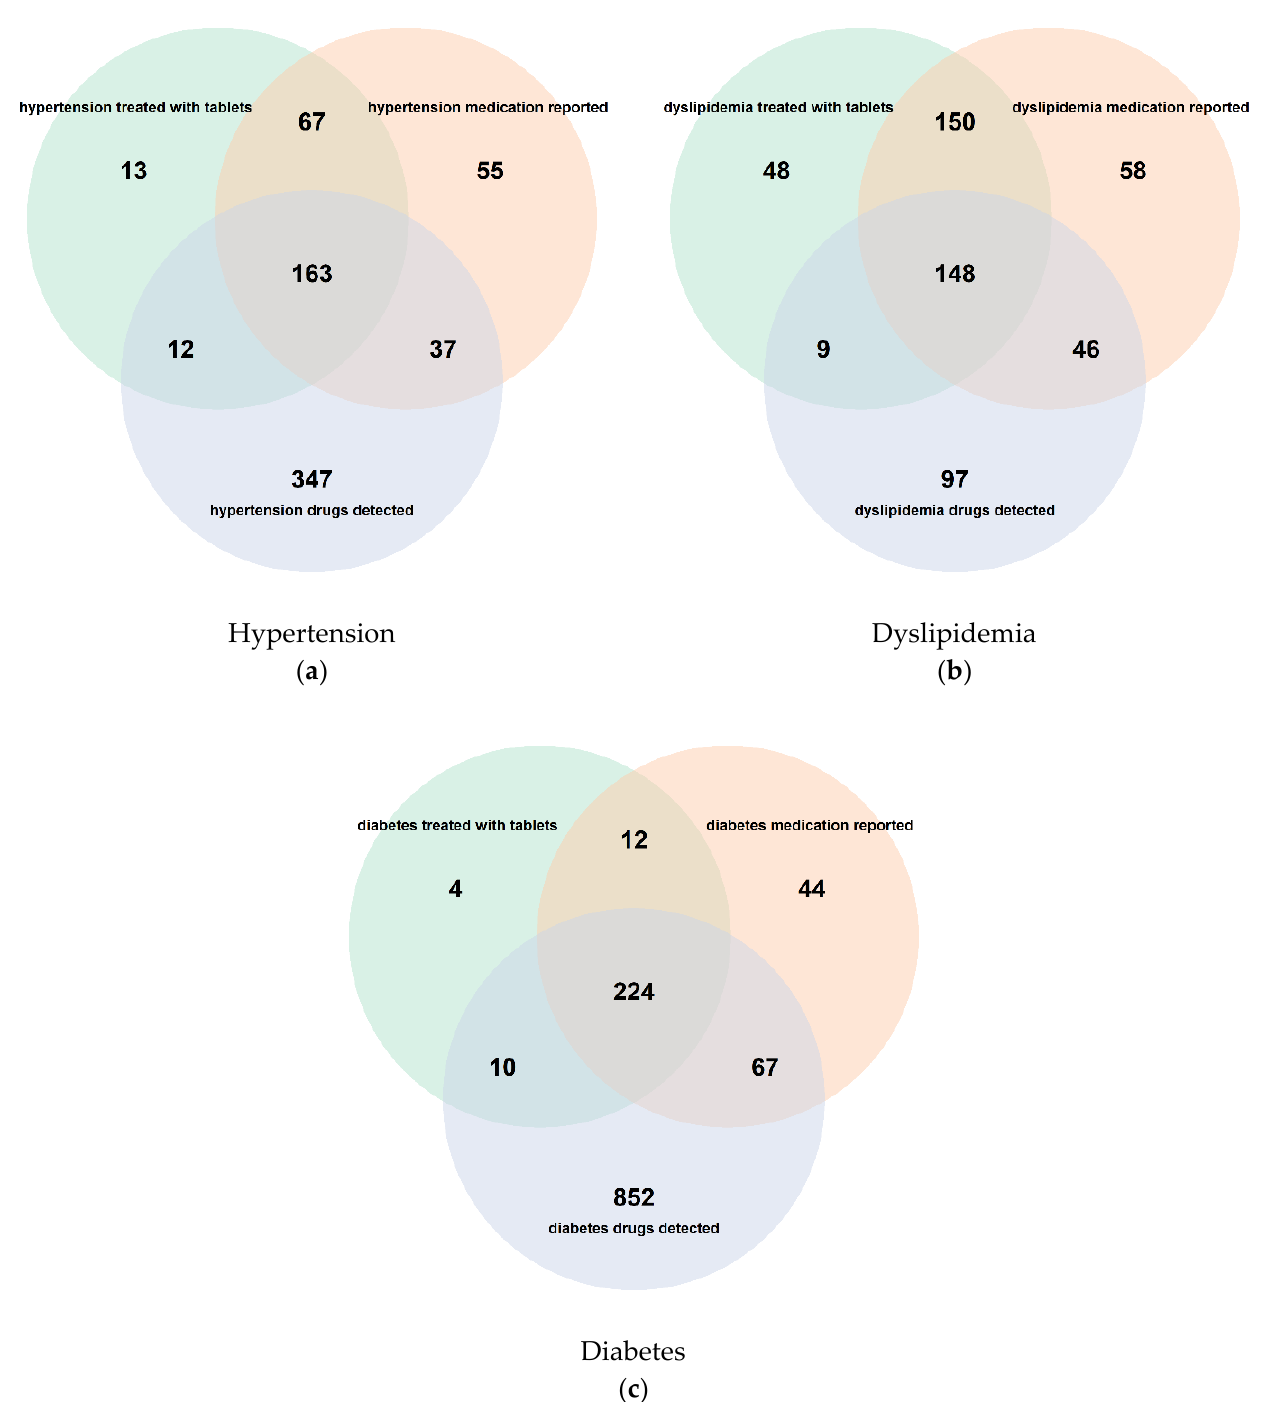
Figure 4. Overlap between individuals who gave an affirmative answer to the question of whether they were treated for a given disorder with tablets (green), who self-reported the use of at least one medication with an indication for the given disorder (orange), and who provided a blood sample with at least one metabolite of a drug with an indication for the given disorder detected (blue); the given disorders were hypertension ( a ), dyslipidemia ( b ), and diabetes ( c ).